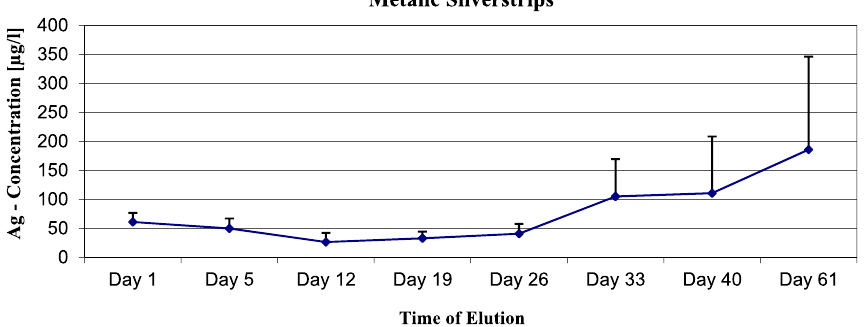
Figure 2. Pure metallic silver strips—static elution model—max. Concentration of silver ions 185.9 µg/l.